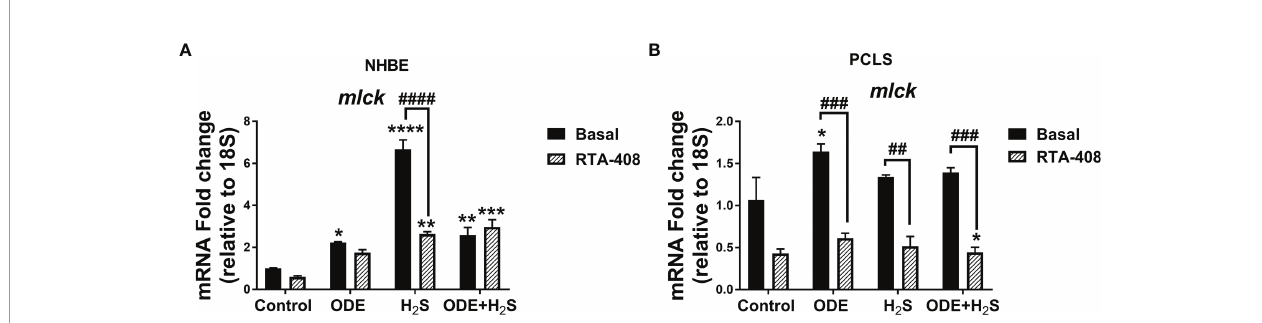
FIGURE 12 | RTA-408 treatment decreased the MLCK transcript. RT-qPCR (n=3/group) was performed to measure the fold change in mlck mRNAs (a-f) in NHBE cells (A) and PCLS (B) . Repeated exposure to ODE or H 2 S or ODE+H 2 S in NHBE cells signi fi cantly increased the folds of mlck transcripts (A) and ODE signi fi cantly increased the folds of mlck transcript as compared to basal control in PCLS model (B) . RTA-408 pre-treatment signi fi cantly decreased the folds of mlck transcripts in H